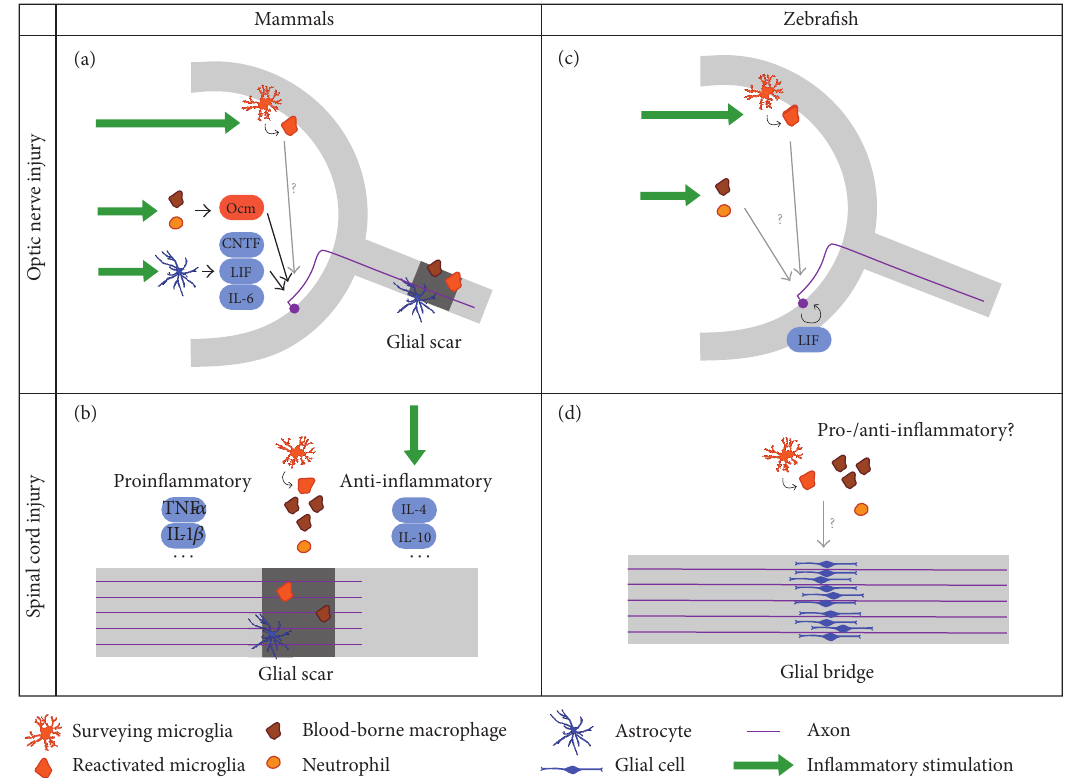
Figure 1: Summary of the current knowledge of the role of acute inflammation in axonal regeneration, in mammals and zebrafish. (a) After optic nerve injury in mammals, surveying retinal microglia become reactivated, proliferate, and transform into amoeboid microglia. Inflammatory stimulation (green arrows), which can be achieved via administration of TLR2 agonists or lens injury, further induces micro- and macroglial cell activation and an influx of neutrophils and blood-borne macrophages to the vitreous. Infiltrating macrophages and neutrophils secrete oncomodulin (Ocm), an inflammatory mediator that is thought to act on RGCs directly. Moreover, inflammatory stimulation elicits the secretion of IL-6 family cytokines from reactive astrocytes. Signal transduction of these cytokines is primarily mediated via the JAK/STAT3 and mTOR pathways in RGCs. Thus, inflammatory stimulation activates the intrinsic growth state of RGCs, and when combined with SOCS3 and/or PTEN deletion, feedback inhibitors of the JAK/STAT3 and mTOR pathway, respectively, axon regeneration beyond the glial scar can be obtained. (b) After an injury in the mammalian spinal cord microglia are activated, and neutrophils and blood-borne macrophages are recruited to the lesion site. Microglia/macrophages mostly adopt the proinflammatory phenotype and secrete proinflammatory cytokines such as TNF- 𝛼 and IL-1 𝛽 , while anti-inflammatory microglia/macrophages, which produce anti-inflammatory cytokines including IL-4 and IL-10, only represent a small percentage. Since the proinflammatory type is associated with adverse effects on regeneration, while anti-inflammatory cells are assumed to be protective and growth-promoting, treatments that stimulate anti-inflammatory activation at the expense of the proinflammatory type (green arrows) improve axonal growth beyond the glial scar and coincide with a better regenerative outcome. (c) Stimulation of acute inflammation after optic nerve injury in zebrafish activates microglia and induces recruitment of neutrophils and blood-borne macrophages, mirroring the situation in mammals. This results in an acceleration of the spontaneous regenerative process. Although it has already been shown that LIF and the JAK/STAT3 and mTOR pathways are implicated in optic nerve regeneration in zebrafish as well, the precise mechanism of how the positive effects of acute inflammation is mediated remains elusive. (d) Afteraspinalcordinjuryinzebrafish,microgliaareactivatedandneutrophilsandblood-bornemacrophagesinfiltratethelesionsite,although their precise contribution to axonal regeneration is still unknown. Despite pro- and anti-inflammatory macrophages have been described in zebrafish injury models outside the CNS, the polarization of microglia/macrophages after spinal cord injury has not yet been studied. Strikingly, a growth-permissive glial bridge is formed at the lesion site, while glial scar is absent in